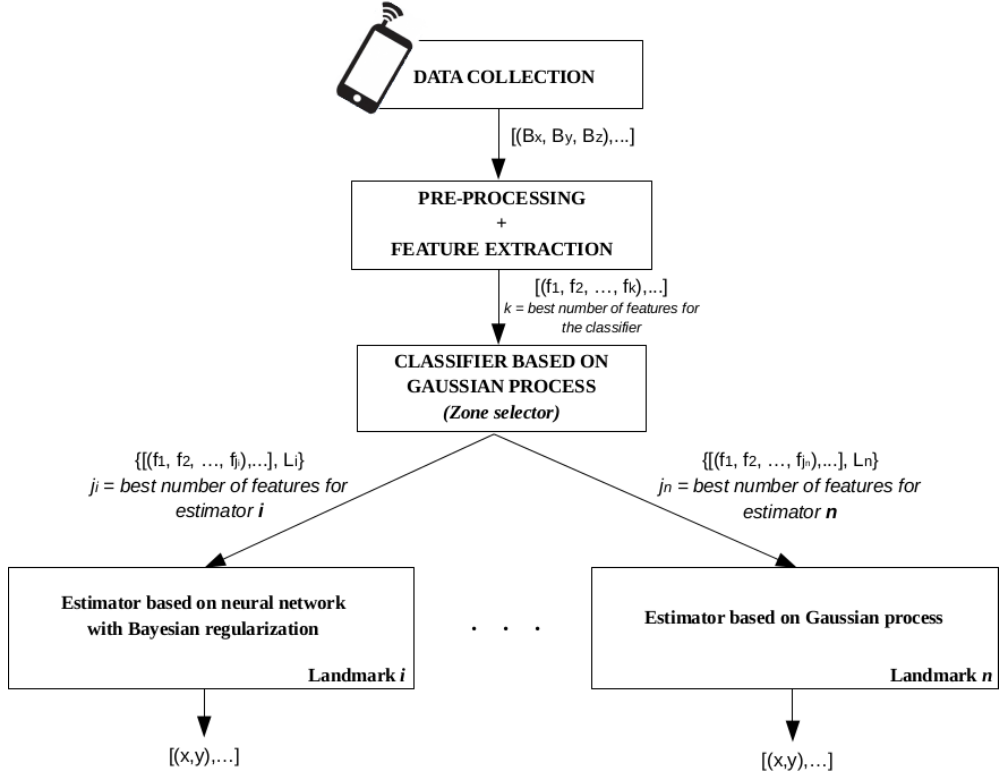
Figure 7. Online phase of the MagicFinger